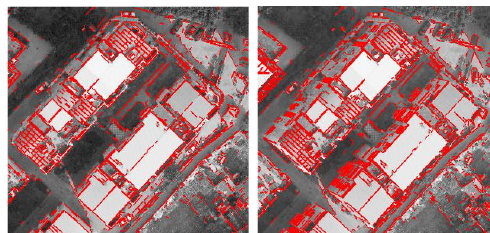
Fig. 9. Patch #1 – LSD: 2128 and 2453 lines extracted